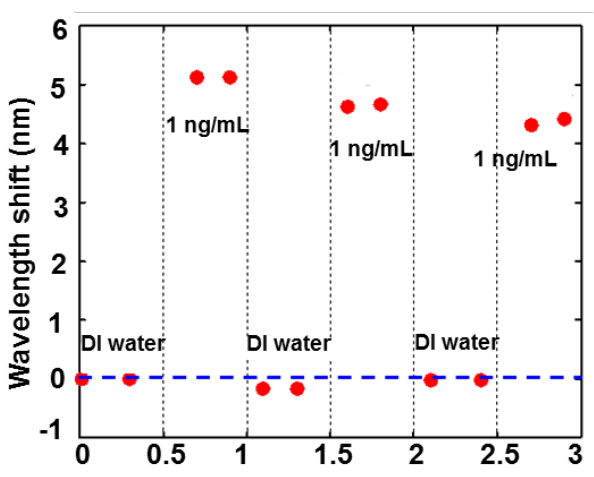
Figure 6. Resonant wavelength shift of the sensor for 1 ng/mL testosterone after each